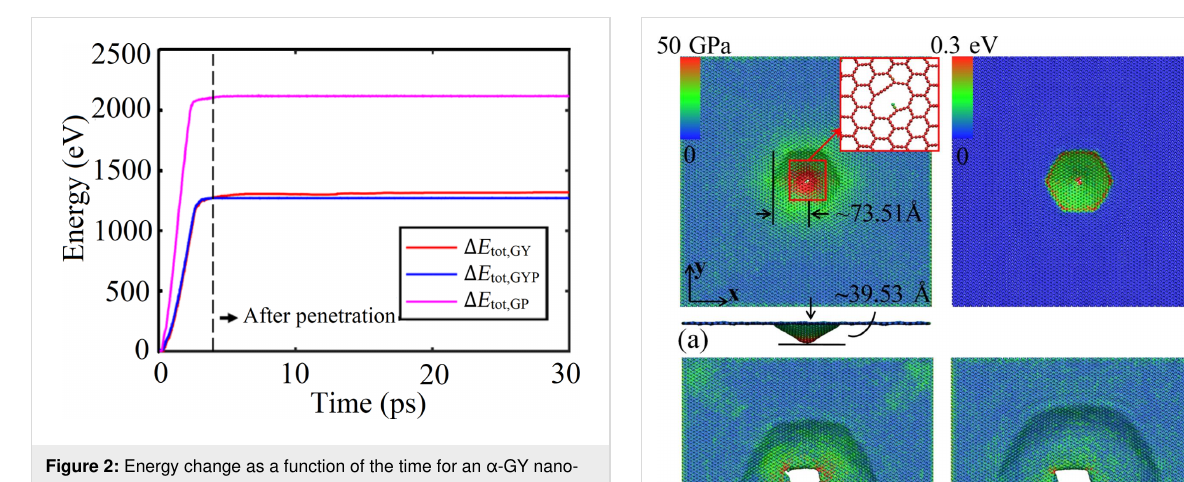
Figure 2, Δ E tot,GYP nearly overlaps with Δ E tot,GY before pene-